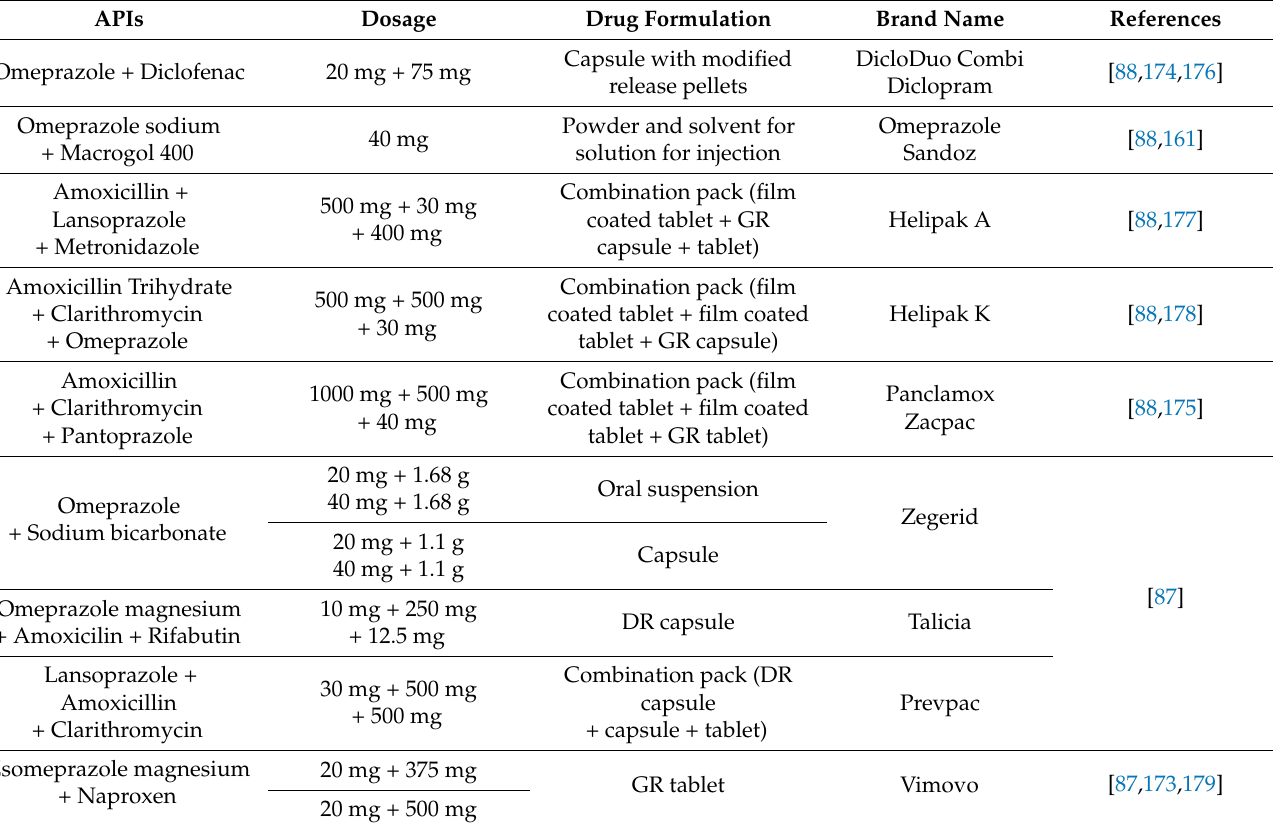
Table 4. Examples of proton pump inhibitors in fixed-dose combination products (available in the U.S. and/or